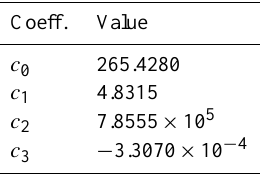
Table 2. Equation coefficients for 3rd degree best-fit polynomial (Eq. 2), as shown in Fig. 6. Coeff.